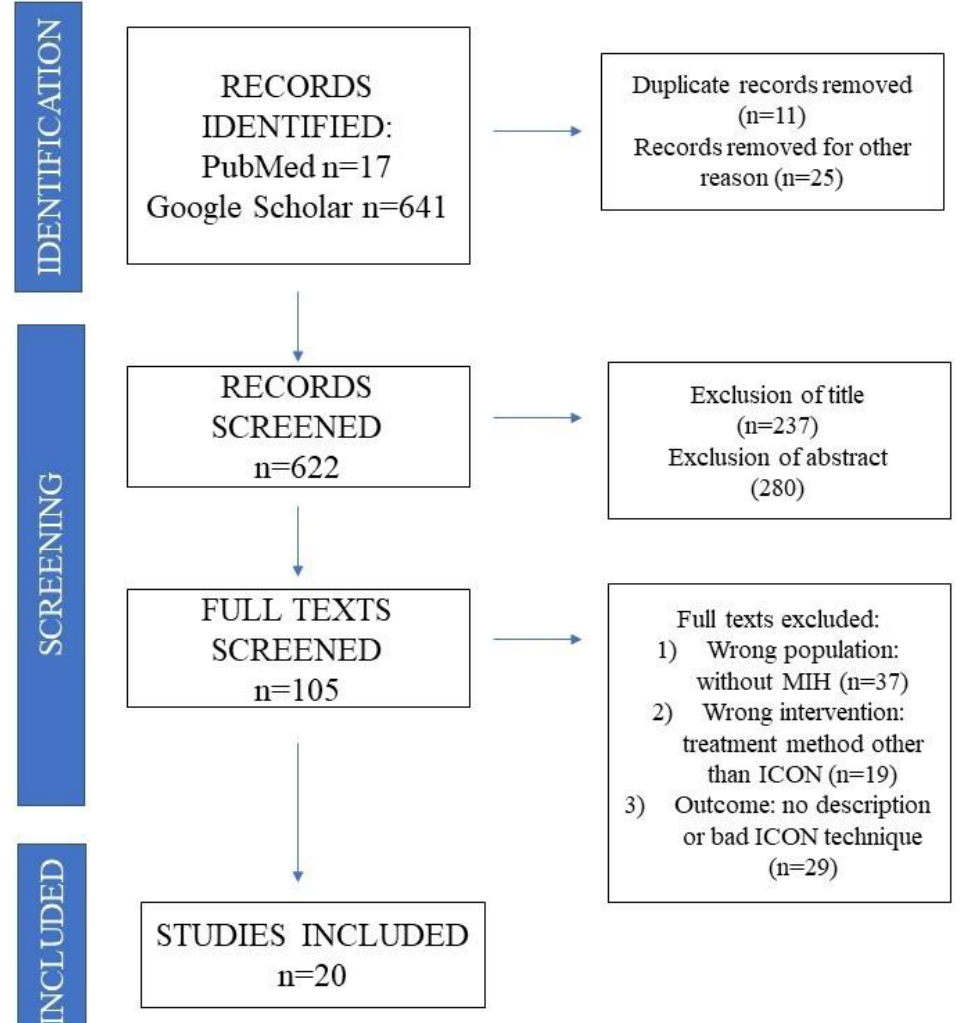
Figure 1. PRISMA flowcharts illustrating the inclusion and exclusion criteria.